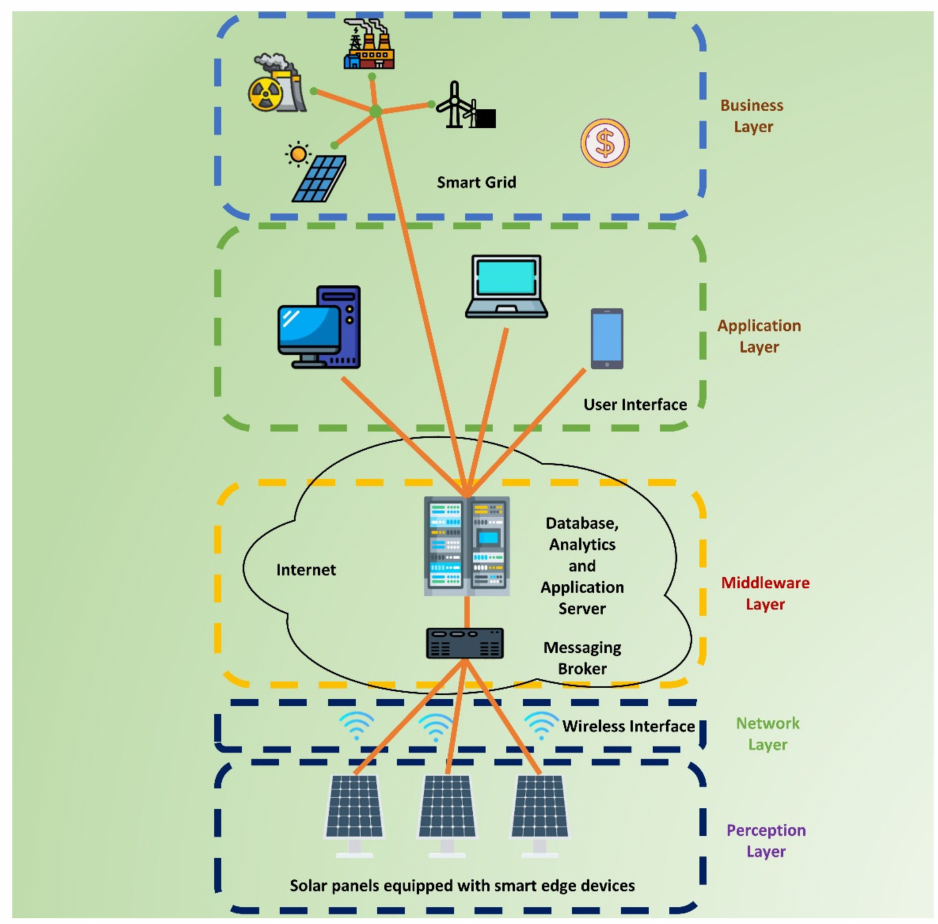
Figure 6. IoT-based PV power monitoring and control